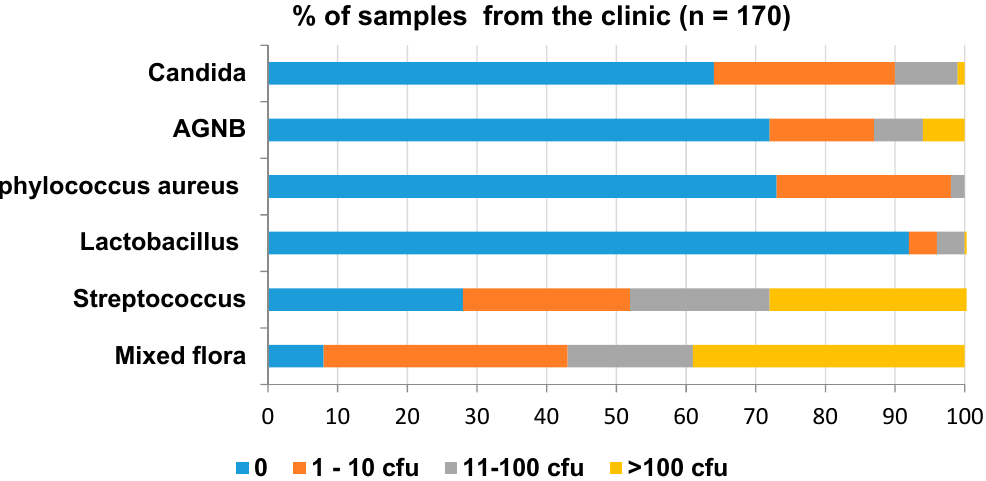
Figure 3. Overall level of contamination in the clinic during denture fabrication.